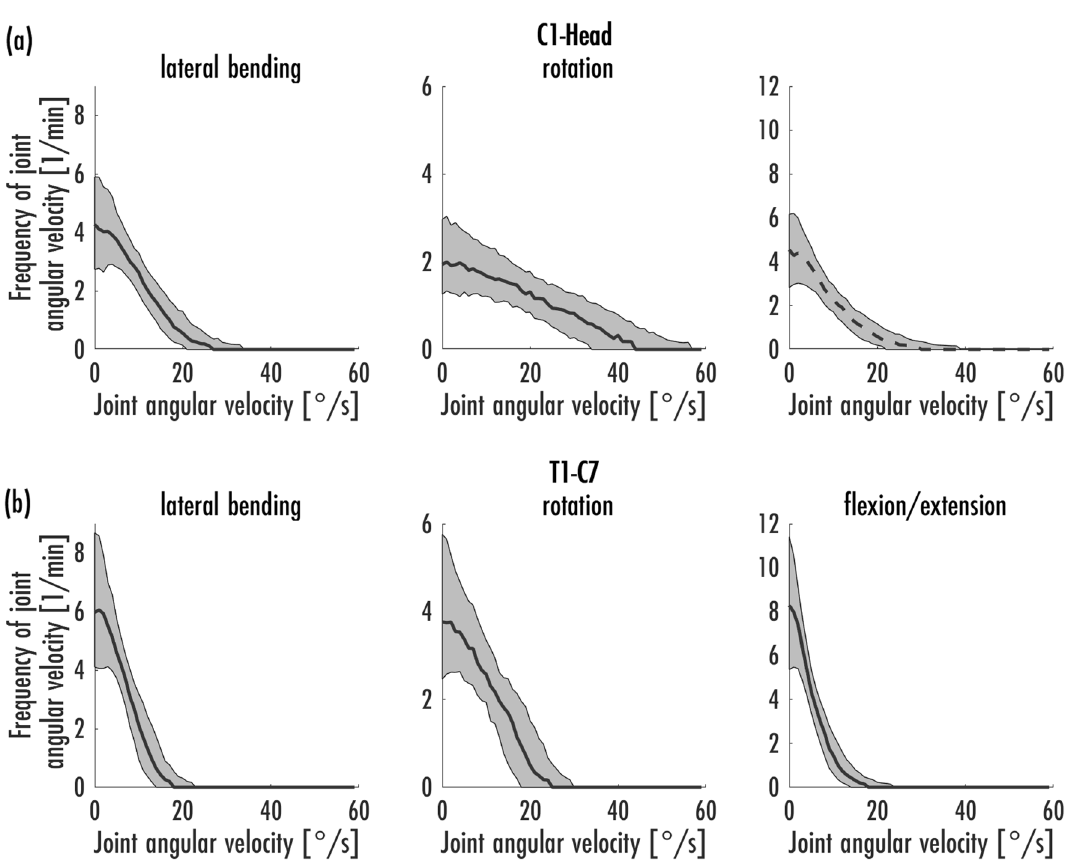
Figure 4. Frequencies of joint angular velocity [1/min] in the areas C1-Head ( a ) and T1-C7 ( b ) in habitual vacuuming [median, 25%- and